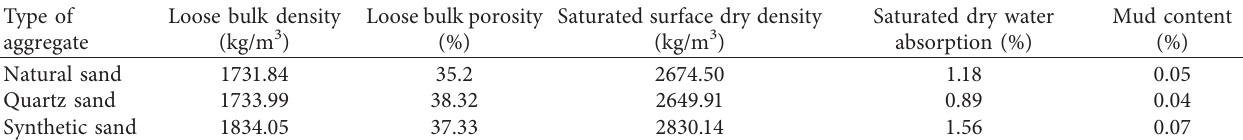
Table 2: Physical index of sand.